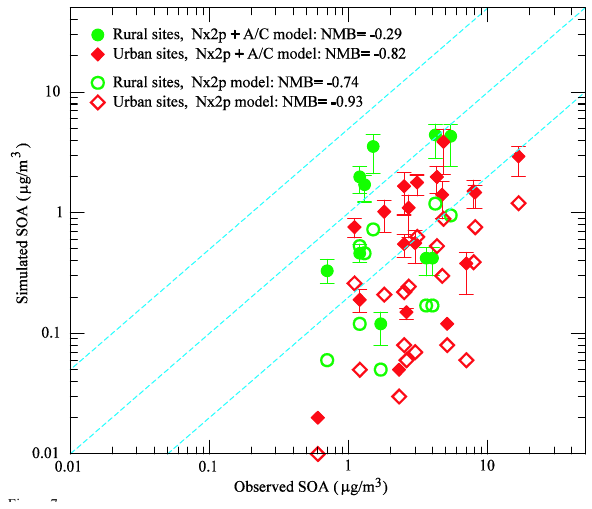
Fig. 7. Comparison of seasonally averaged SOA mass concentra- tions observed at 25 sites around the globe (Jimenez et al., 2009 and references therein) with those in the lower boundary layer (0– 0.4km) simulated with N × 2p (unfilled symbols) and N × 2p+A/C (filled symbols) SOA formation models. The vertical bars over- lapped on filled symbols present the simulated SOA mass concen- trations when the value of geometric standard deviation ( σ g ) in log- normal C ∗ distribution (Eq. 11) is changed from 2.0 (baseline value, filled symbols) to 1.6 (lower end) and to 2.5 (upper end). The solid line shows a 1:1 ratio, and the dashed lines show ratios of 5:1 and